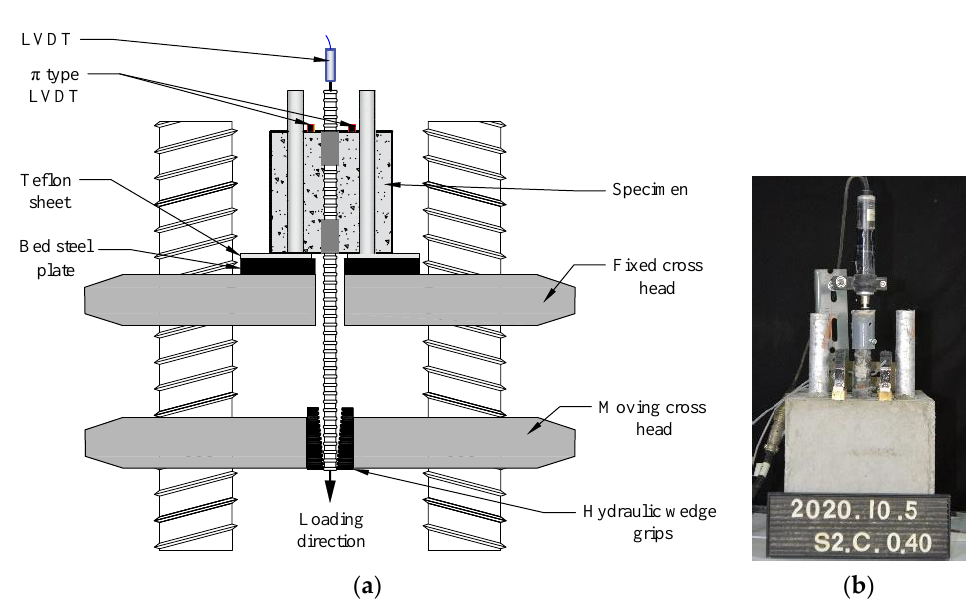
Figure 8. Pull-out setup and measurement method: ( a ) loading machine; ( b ) picture of specimen at loading.